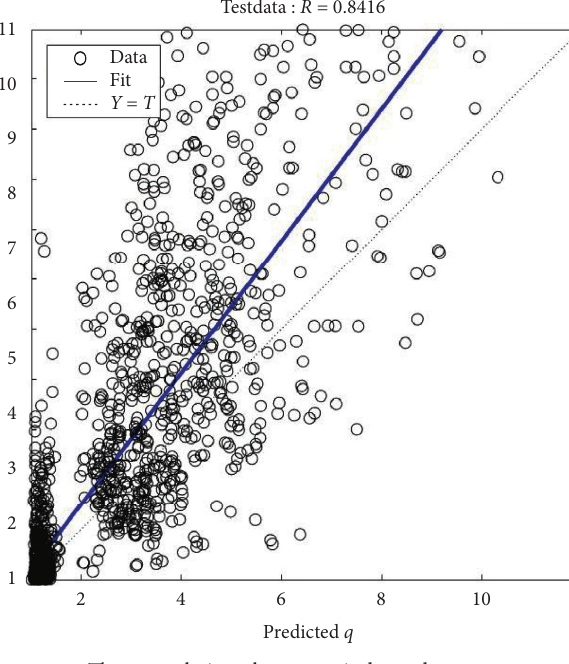
Figure 7: The correlation between independent parameters ( n , λ , α , T , and μ ) and predicted q values from equation (5) (test s p R